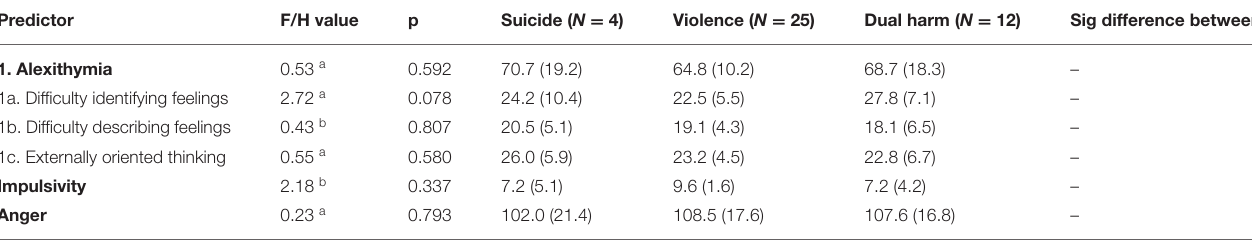
TABLE 4 | ANOVA of dual harm behavior.